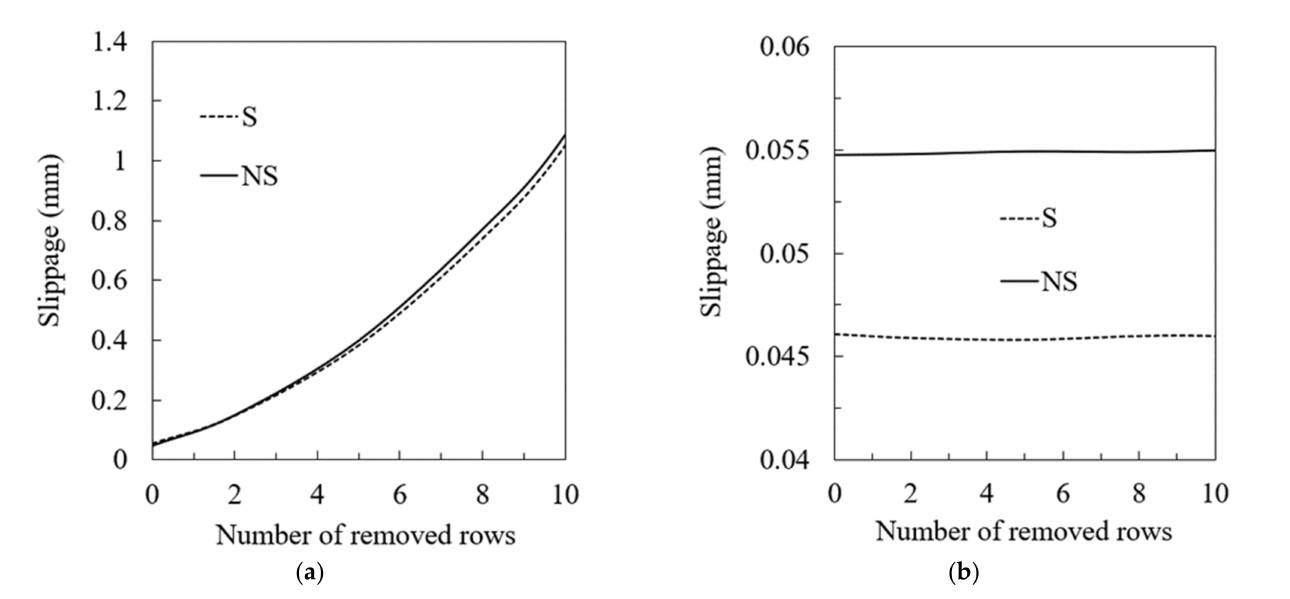
Figure 8. The effect of the progressive failure of studs on the slippage between the steel beam and concrete deck for strengthened and non-strengthened composite beams. ( a ) Removal side. ( b ) Non-removal